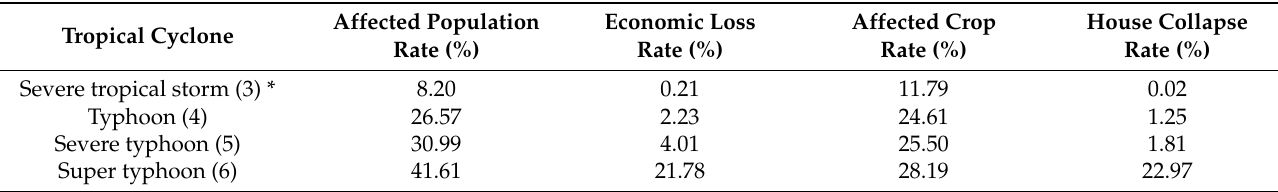
Figure 2. Economic vulnerability curve for different grades of typhoons. Table 3. Vulnerability to typhoons of different levels in Cangnan County.